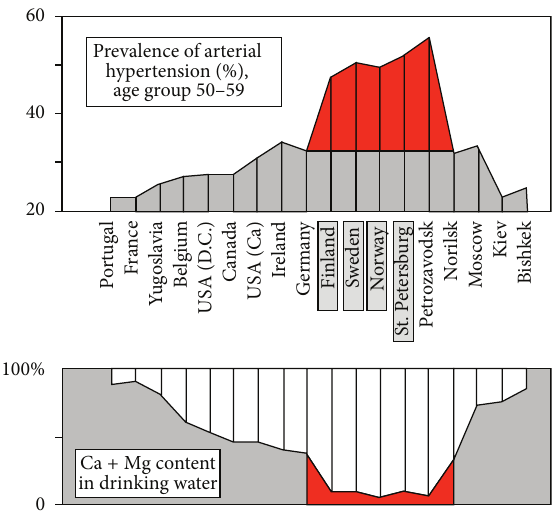
Figure 1: Effect of calcium and magnesium in the drinking water on the incidence of hypertonic disease